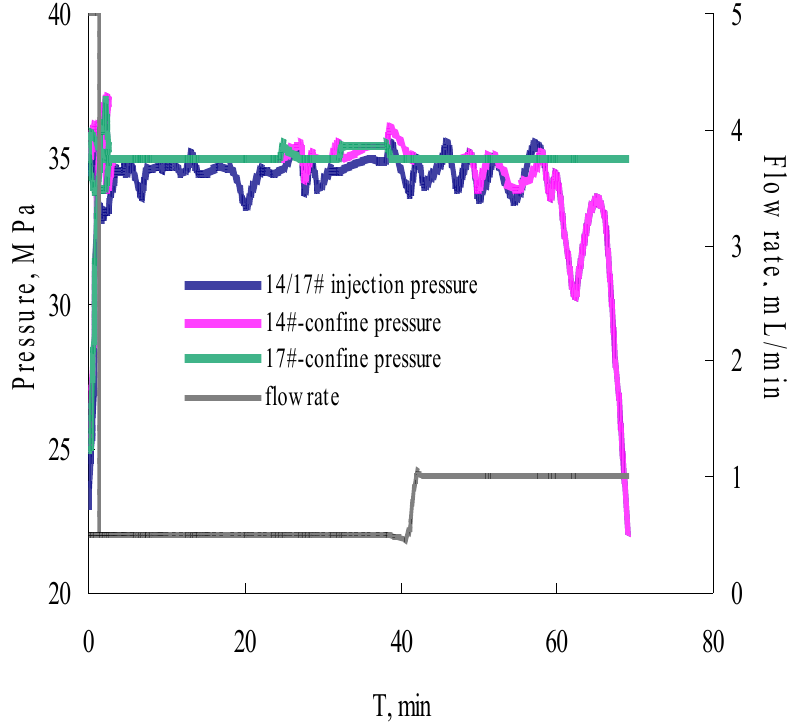
Figure 11. Parameters change with time during the acid fracturing process on two samples (1.5 VES, 18.2% HCl).